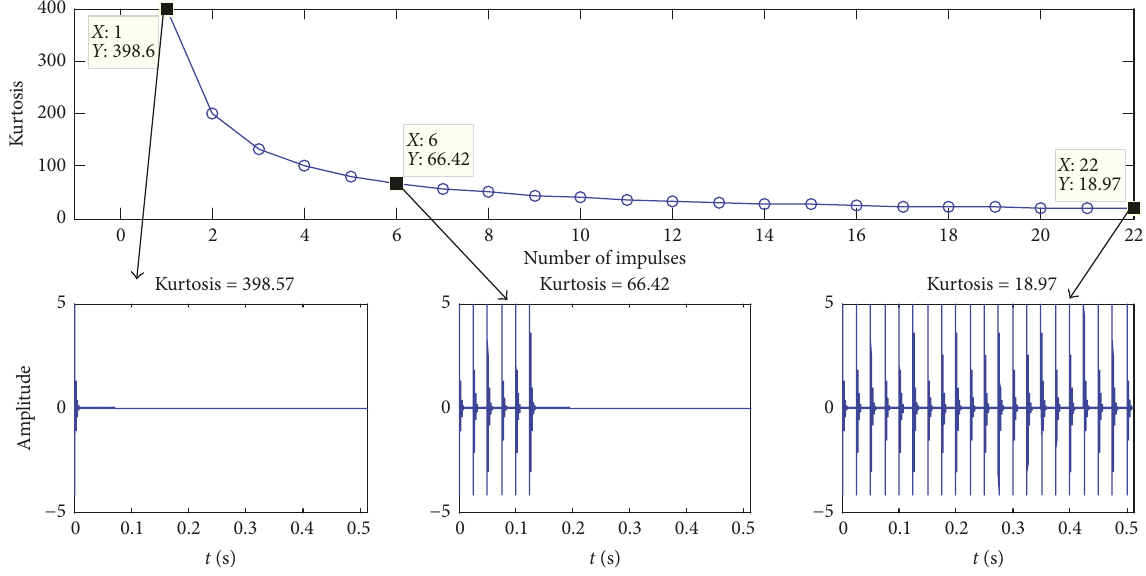
Figure 4: Illustration of kurtosis values for different number of impulses.